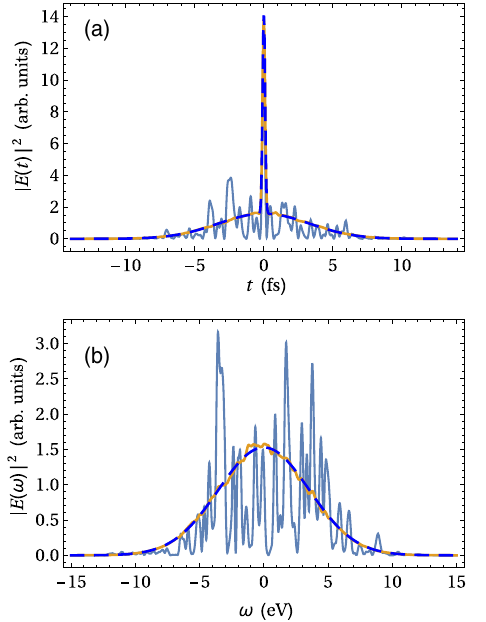
FIG. 4. Intensity profiles of a stochastic UDSP pulse with a ¼ 3 , Λ ¼ 5 meV, τ ¼ 4 . 65 fs ( 1 = τ ¼ 0 . 14 eV), and σ ¼ 5 eV. The (a) temporal and (b) spectral intensity profiles are shown. The blue continuous, yellow continuous, and blue dashed curves have the same meaning as in Fig.